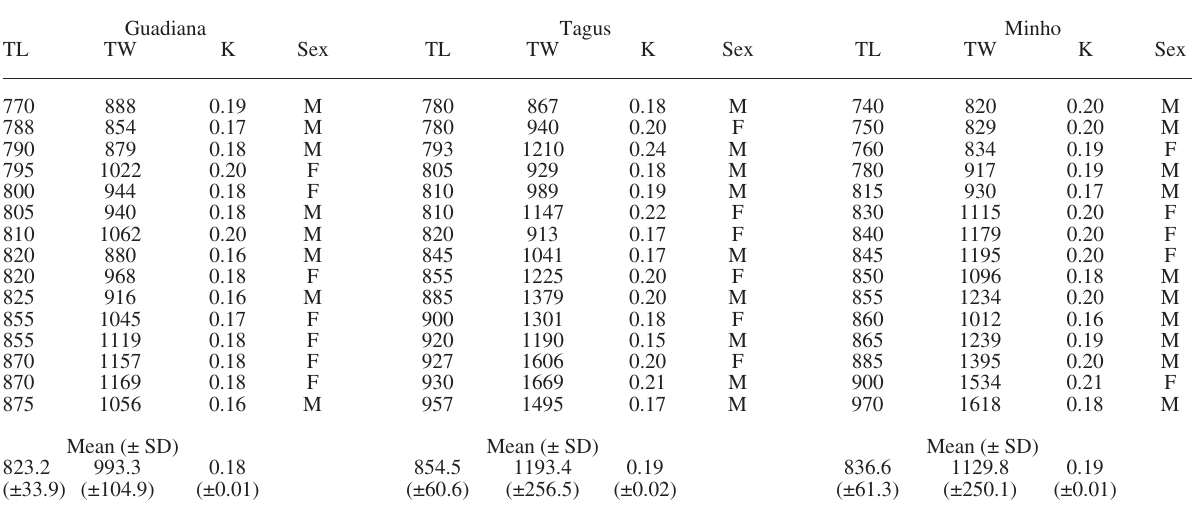
three Portuguese river basins